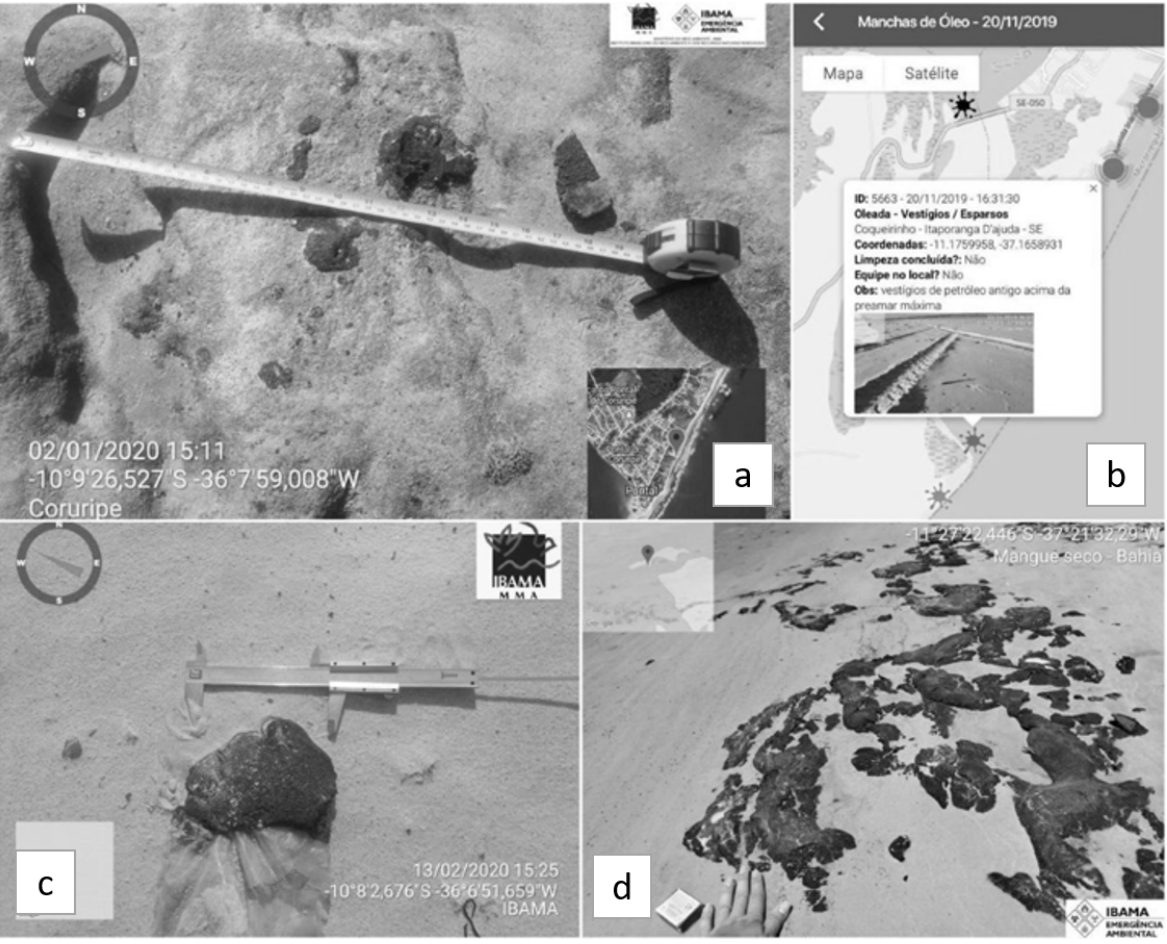
Figure 4. Examples of data in Olhos de Águia application (a - oil fragments compared to a measuring tape; b - view of the application’s output data; c – oil fragment measured with a caliper; d – oil stains compared to the recorder’s